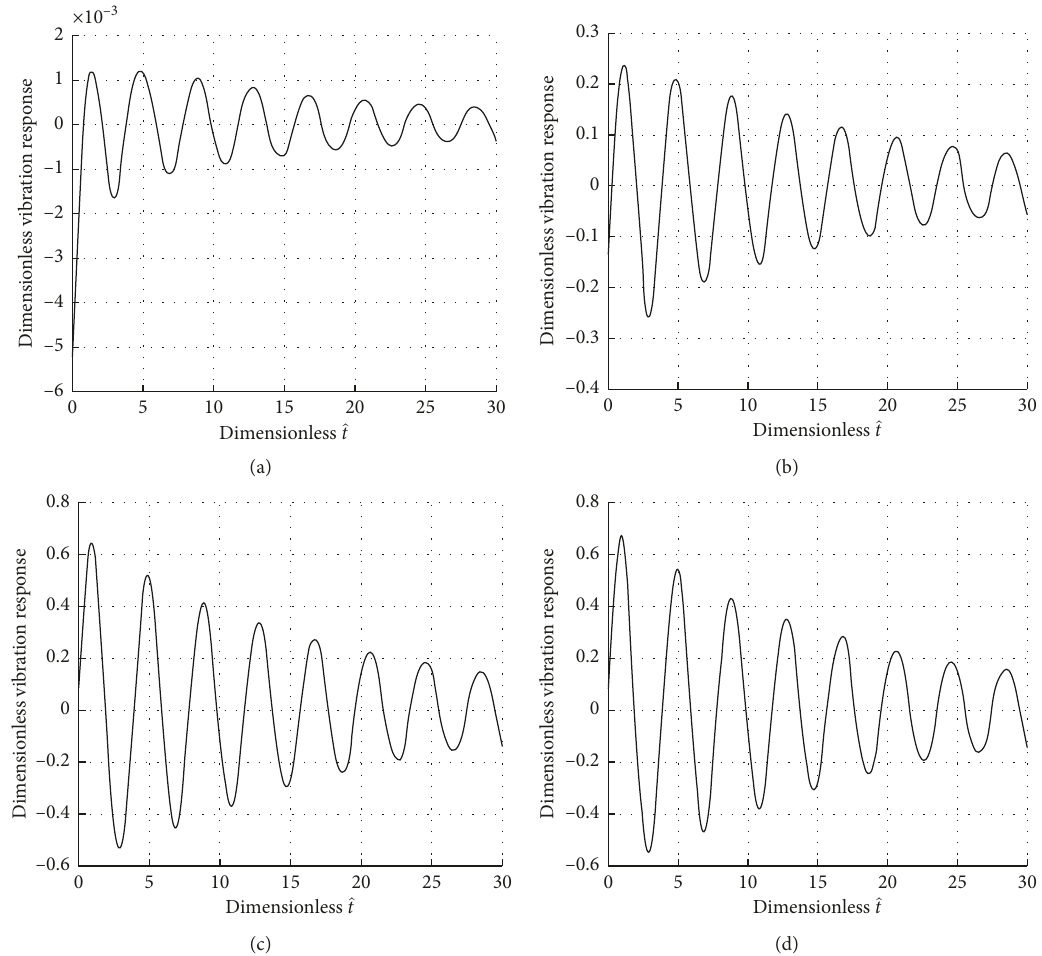
Figure 7: Vibration response curve of fractional derivative Kelvin–Voigt viscoelastic beam at r � 1/30, r � 0 . 02447, (b) ξ α � 1/2. (a) ξ 3